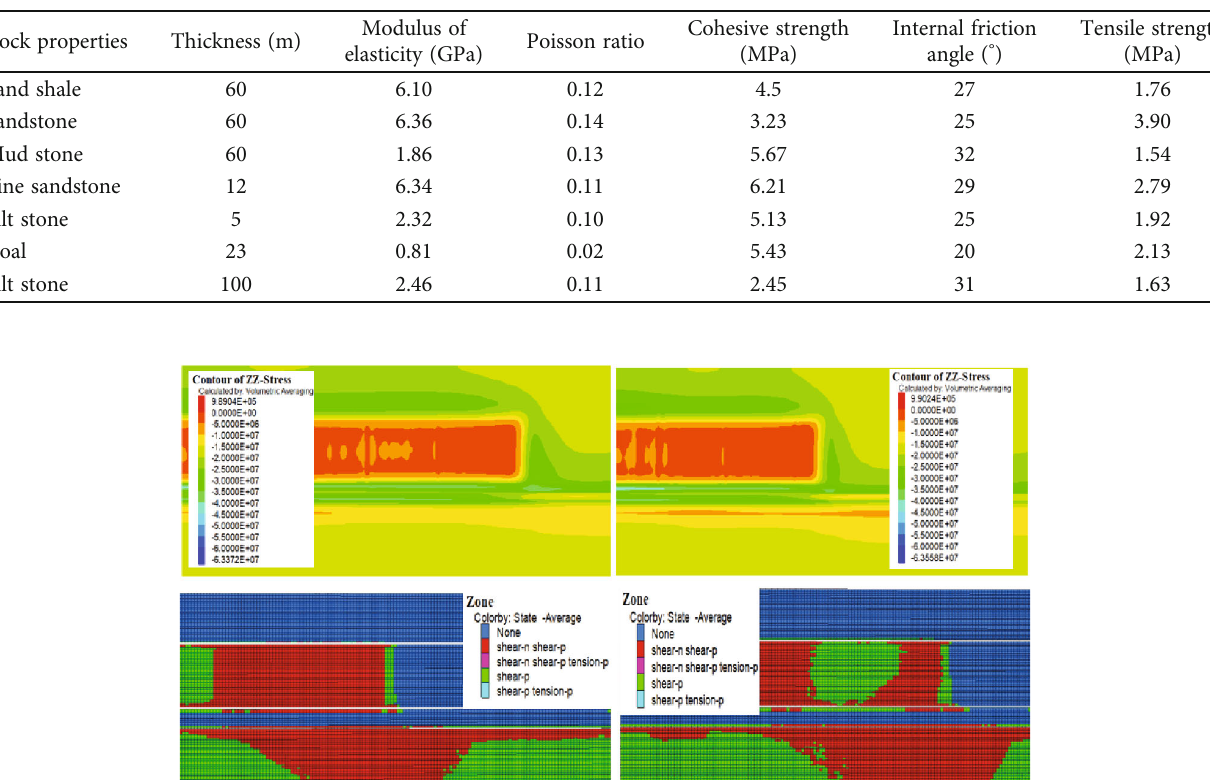
Figure 7: Modeling of the Table 1: Geometry and mechanical parameters of coal and rock.